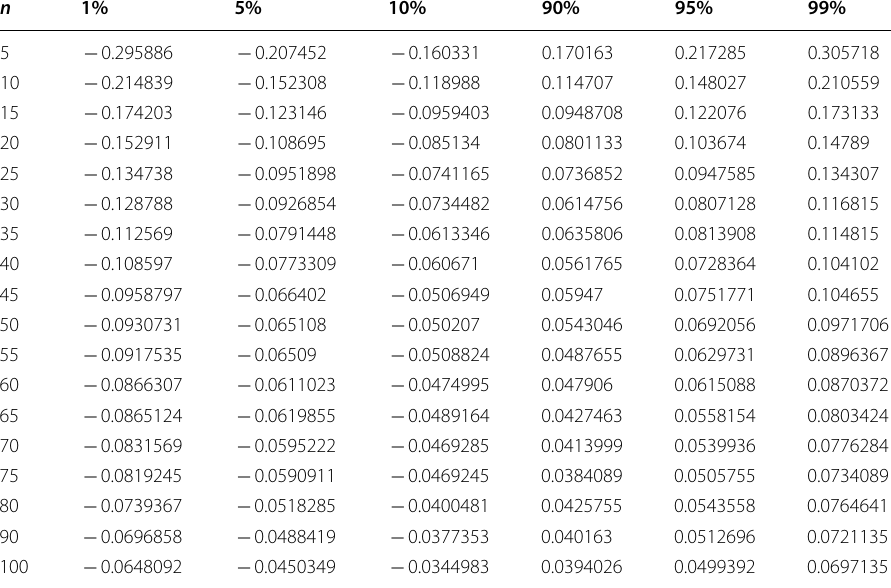
Table 1 Critical values of ˆ (cid:31) U